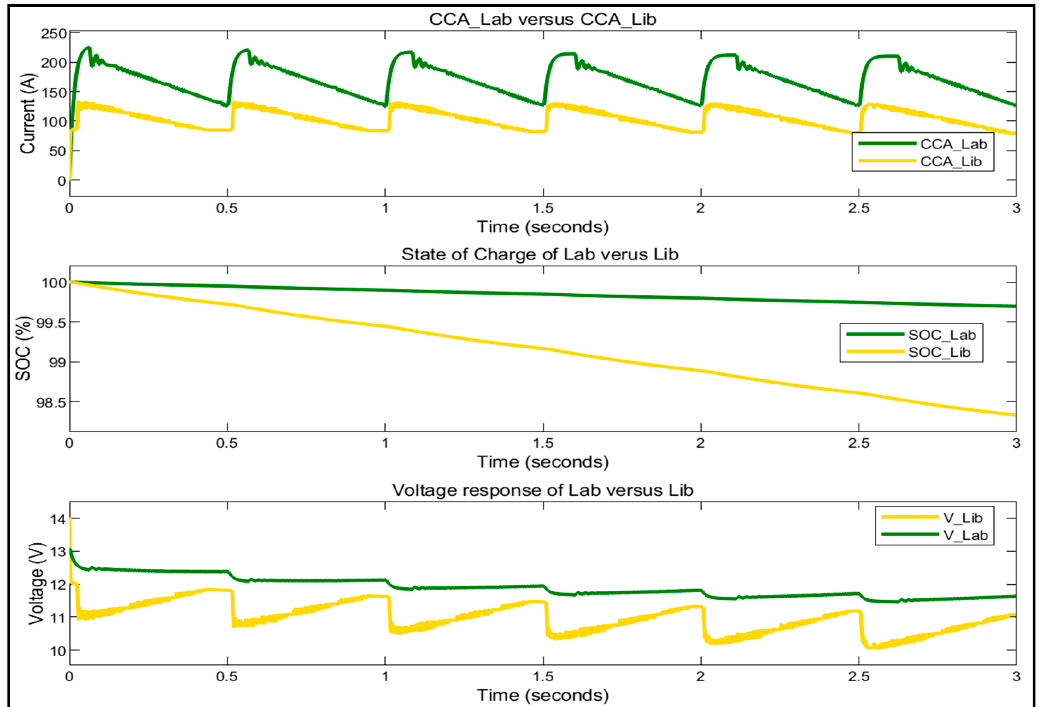
Figure 16. The percentage CCC, SoC , and voltage response of hybridized batteries during discharging mode.